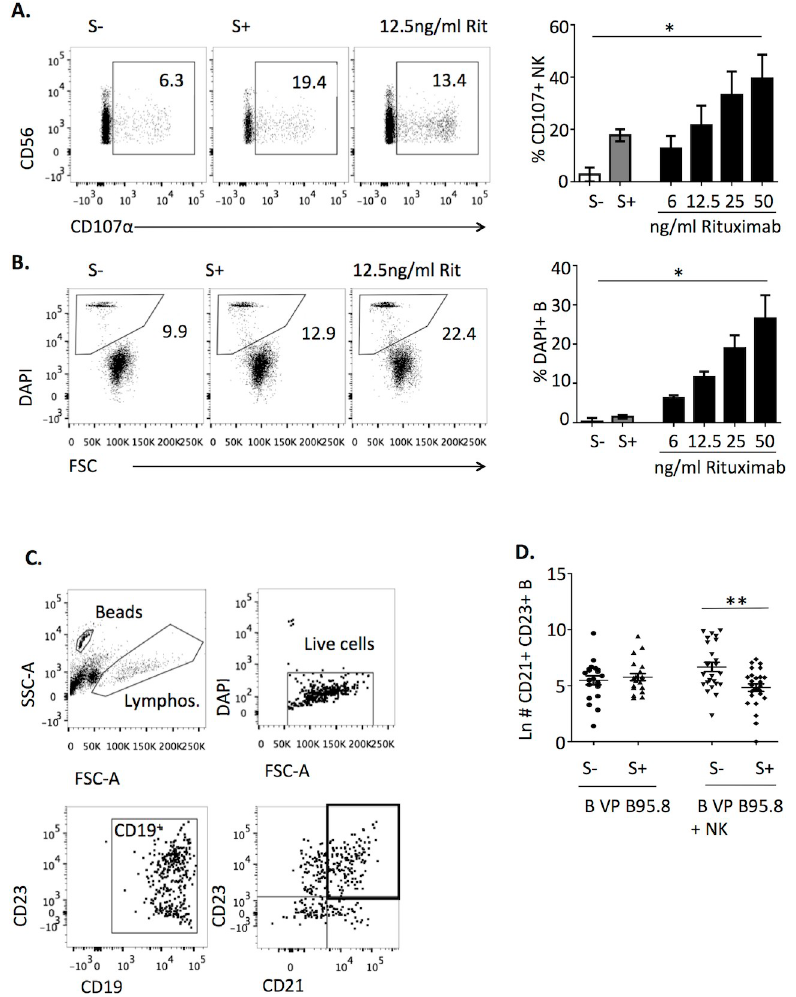
Fig 1. Interaction of NK cells with B cell-bound EBV VP in the presence of EBV S+ reduces transformation without inducing B cell death. ( A , B ) B cells were stained with fluorescent dye, coated with B95.8 VP for 1h at 4˚C, washed, and cultured with autologous NK cells in the presence of EBV S-, EBV S+ serum or the indicated doses of Rituximab. After 4h, the percentages of CD107 α + NK cells ( A ) and of DAPI + B cells ( B ) were determined by flow cytometry. Background levels without B cells (for CD107 α ) or without NK cells (for DAPI) were substracted. Plots of a representative experiment (left) and results of three (right) are shown. Statistical analysis was performed with Friedman test with Dunn’s post-test. ( C , D ) B cells were incubated with B95.8 VP for 1h at 4˚C, washed and cultured alone or with autologous NK cells in the presence of EBV S- or S+ serum for 4h. Subsequently, B cells separated from NK cells were plated at 50,000 cells /well, cultured for 2 weeks and stained for CD19, CD21, CD23 and DAPI. ( C) Representative gating strategy. ( D) Data are expressed as Ln of the number of live CD23 + CD21 + CD19 + cells detected in 20–26 wells per condition from 3 experiments. Statistical analysis was performed with one-way ANOVA test with Bonferroni’s multiple comparison test.